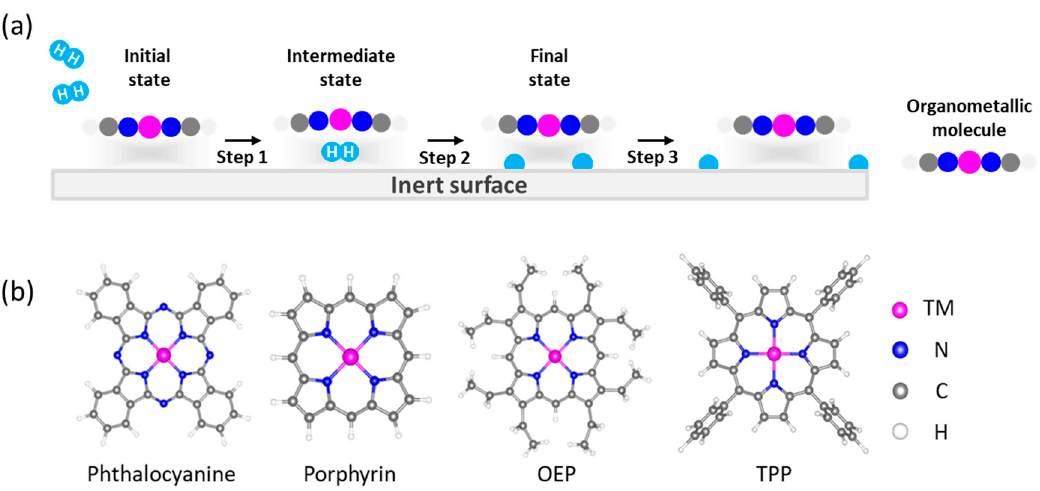
Figure 1. Schematics describing a quantum nutcracker for hydrogen dissociation. ( a ) A quantum nutcracker consists of two inert components as two jaws: an organic molecule and an inert surface. ( b ) The configurations of organic molecule candidates: transition metal phthalocyanine, transition metal porphyrin, transition metal octaethylporphyrin (OEP), and transition metal tetraphenylporphyrin (TPP).